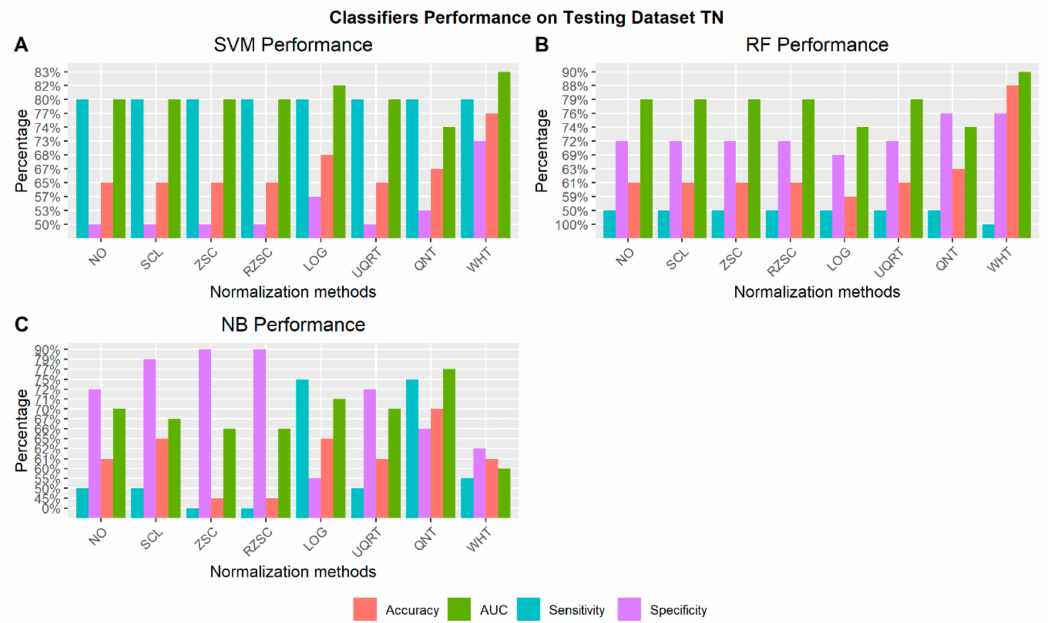
Figure 10. Classifiers performance on testing dataset to identify TN cases via radiomic features across normalizationmethods(NO:non-normalizedfeatures; SCL:Scalingnormalizationmethod; ZSC:Z-score normalization method; RZSC: Robust Z-score normalization method; LOG transformation; UPQRT: Upper Quartile normalization methods; QNT: Quantile normalization method; WHT: Whitening normalization method). A ) Support Vector Machine (SVM) Performance on Testing dataset TN vs Others. B ) Random Forest (RF) Performance on Testing dataset TN vs Others. C ) Naïve Bayesian (NB) Performance on Testing dataset TN vs Others.